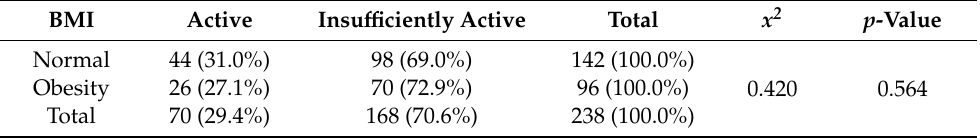
Table 3. Physical activity in relation to obesity assessed by chi-squared